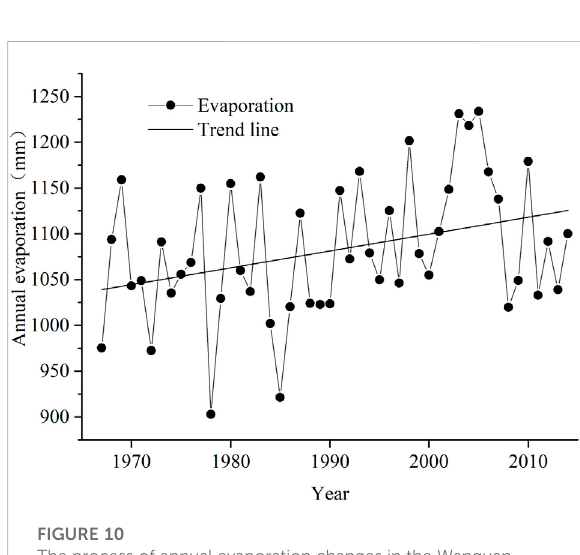
FIGURE 7 The process of runoff changes with land use change in the Wanquan river basin.